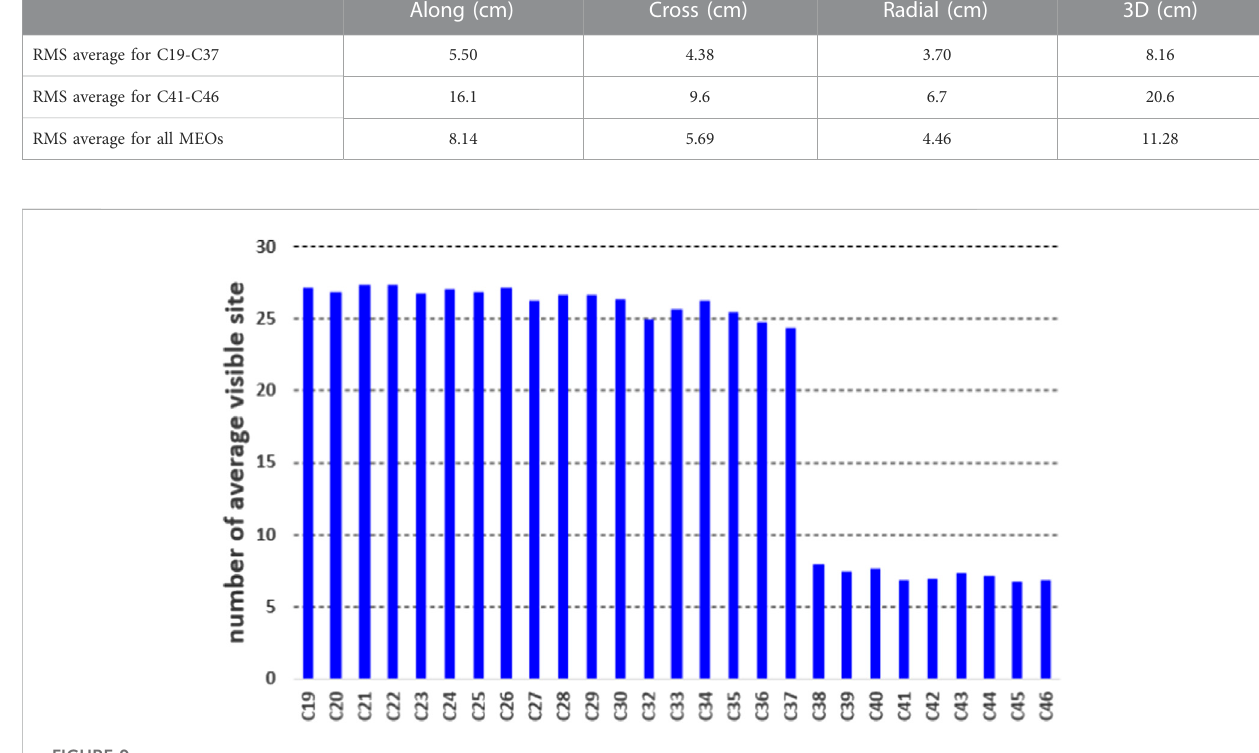
FIGURE 9 Number of average visible stations for every